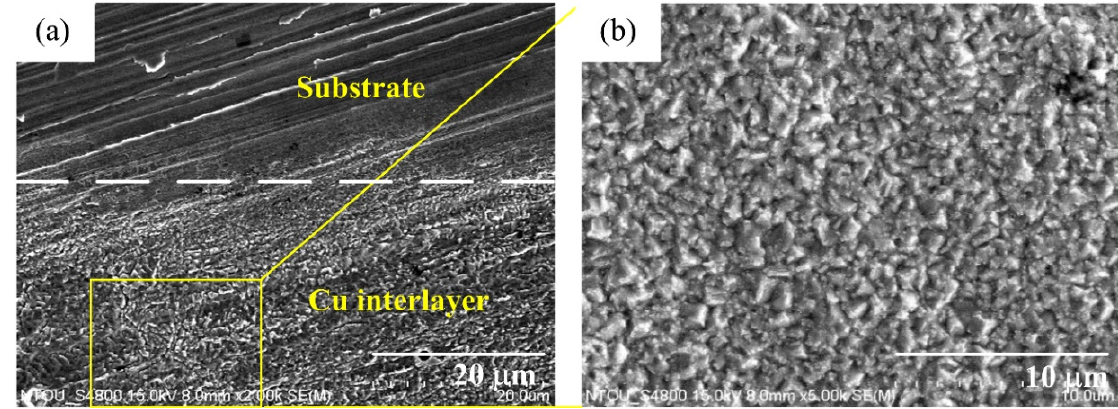
Figure 3. Microscopic morphology of the plated Cu interlayer. ( a ) the plated Cu interlayer partially on substrate (lower part), and ( b ) the magnified Cu interlayer.